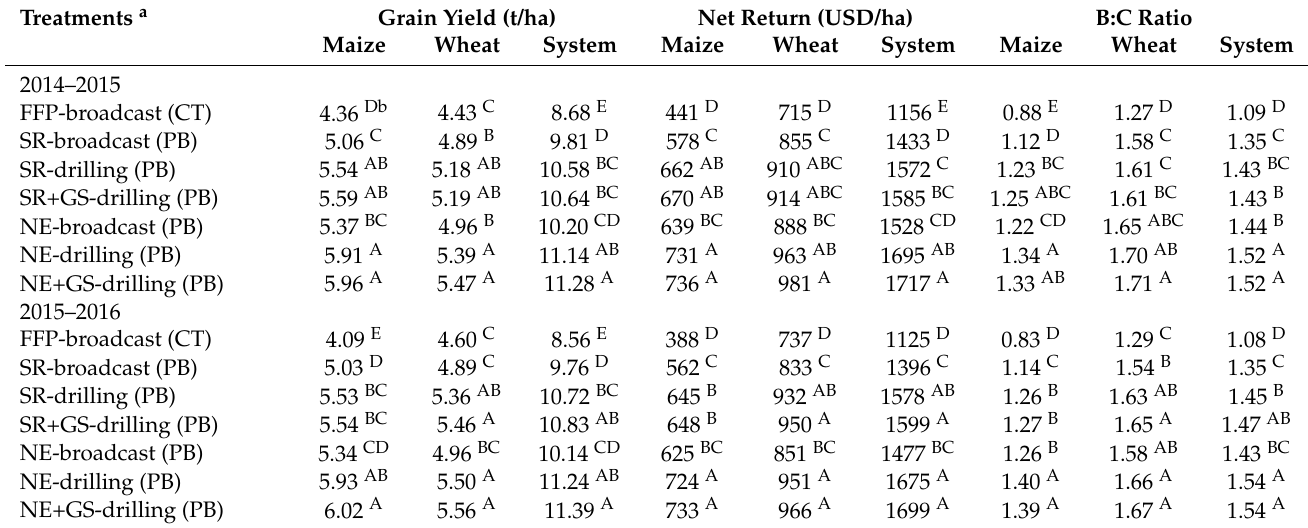
a Refer Table 2 for details of nutrient management treatments. b Within year, crops and cropping system, means under different nutrient